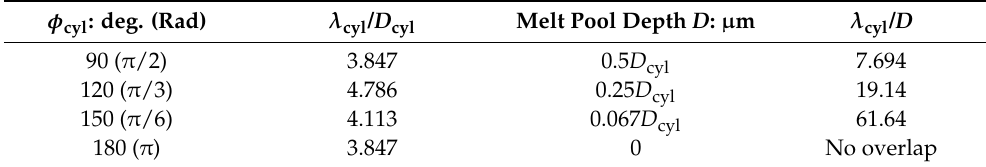
Table 2. The φ cyl , λ cyl / D cyl , melt pool depth, and λ cyl / D of a segmented cylindrical melt pool model shown in Figure 8.